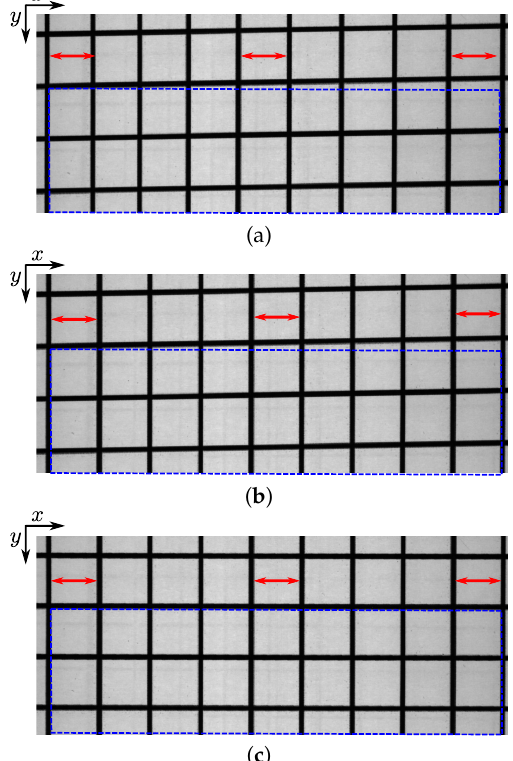
Figure 4. Images of the 49th channel of the acquisition of the grid made of perfect squares without corrections ( a ), after sensor correction ( b ) and after sensor and affine correction ( c ). Without corrections, the pixel resolution increases w.r.t. the x coordinate (sides of squares are higher to the right of the image than to the left). After corrections, the pixel resolution is constant w.r.t. the x coordinate (sides of squares remain constant). Moreover, the shear distortion is reduced after sensor and affine correction since the squares have right angles. The red arrows and blue rectangles have been added as overlays to obtain a better view of the distances and angles. Note that they are identical (same lengths) from one image to